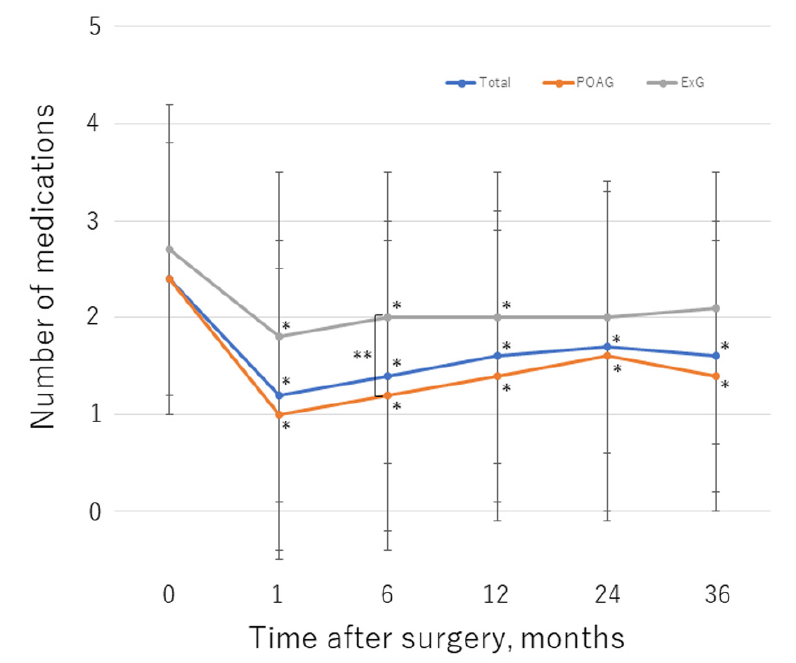
Figure 4. Changes in mean number of glaucoma medications over the course of follow-up. *, statistically significant difference between the preoperative value and each time point. **, statistically significant difference between the POAG and ExG group. Error bar shows the standard deviation. ExG, exfoliation glaucoma; POAG, primary open-angle glaucoma.